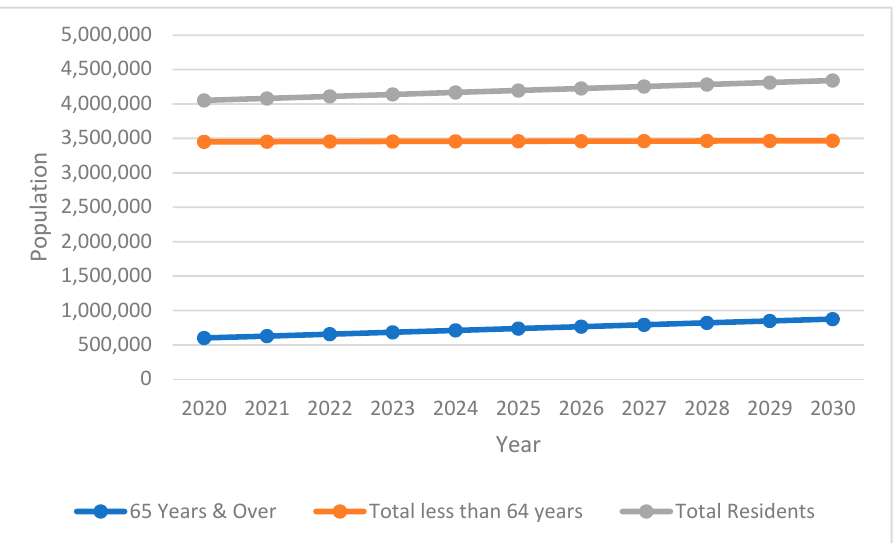
Figure 3. Projection of Singapore Residents by Age Group: 2020 to 2030. Source: Developed for the study.